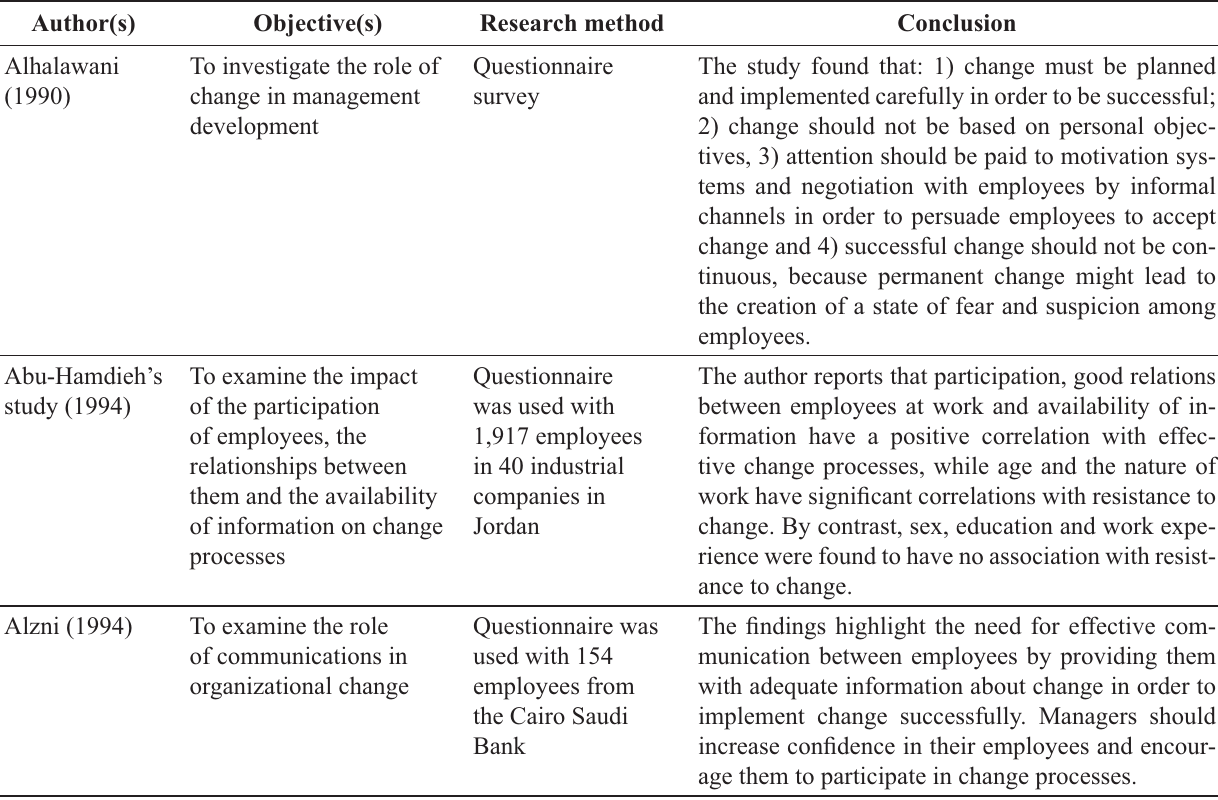
Table 1. Review of organizational change management literature in the Arab